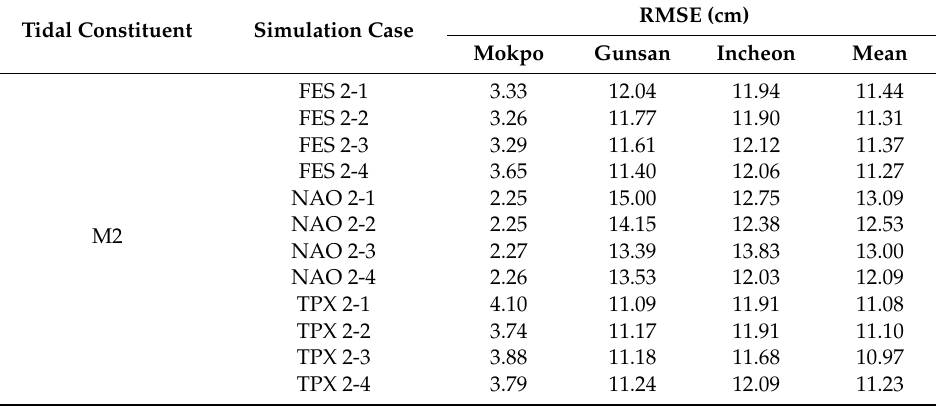
Table A6. RMSE results obtained from non-uniform roughness bottom for